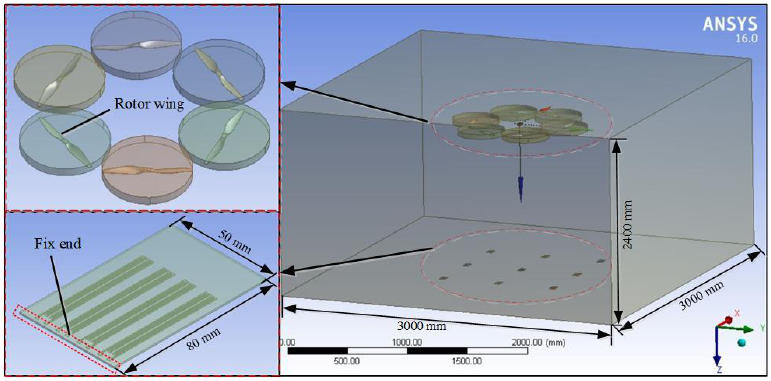
Figure 4. One-way fluid-solid coupling field modeling.